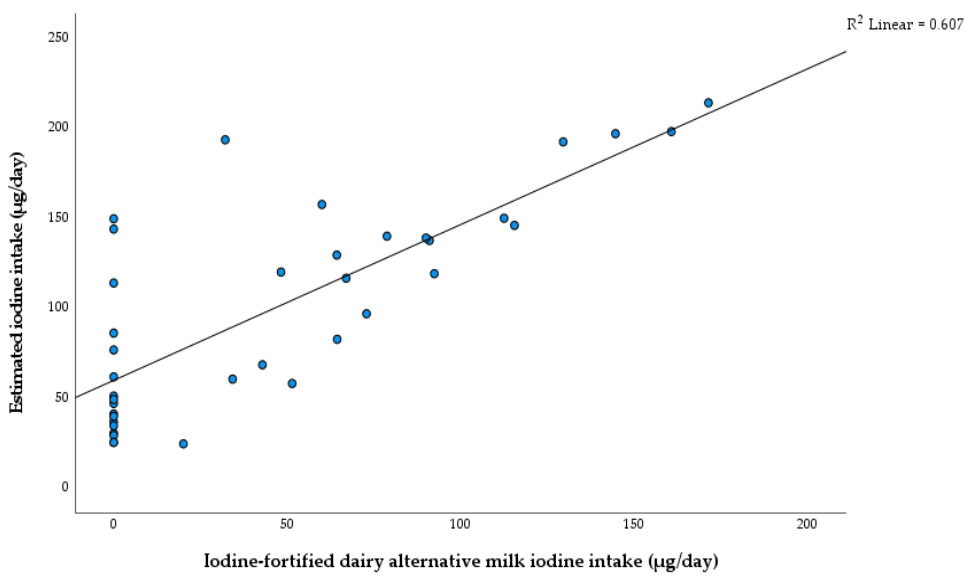
Figure 4. Correlation between estimated iodine intake ( µ g/day) and iodine-fortified dairy alternative milk iodine intake ( µ g/day) for children aged 1–18 years.